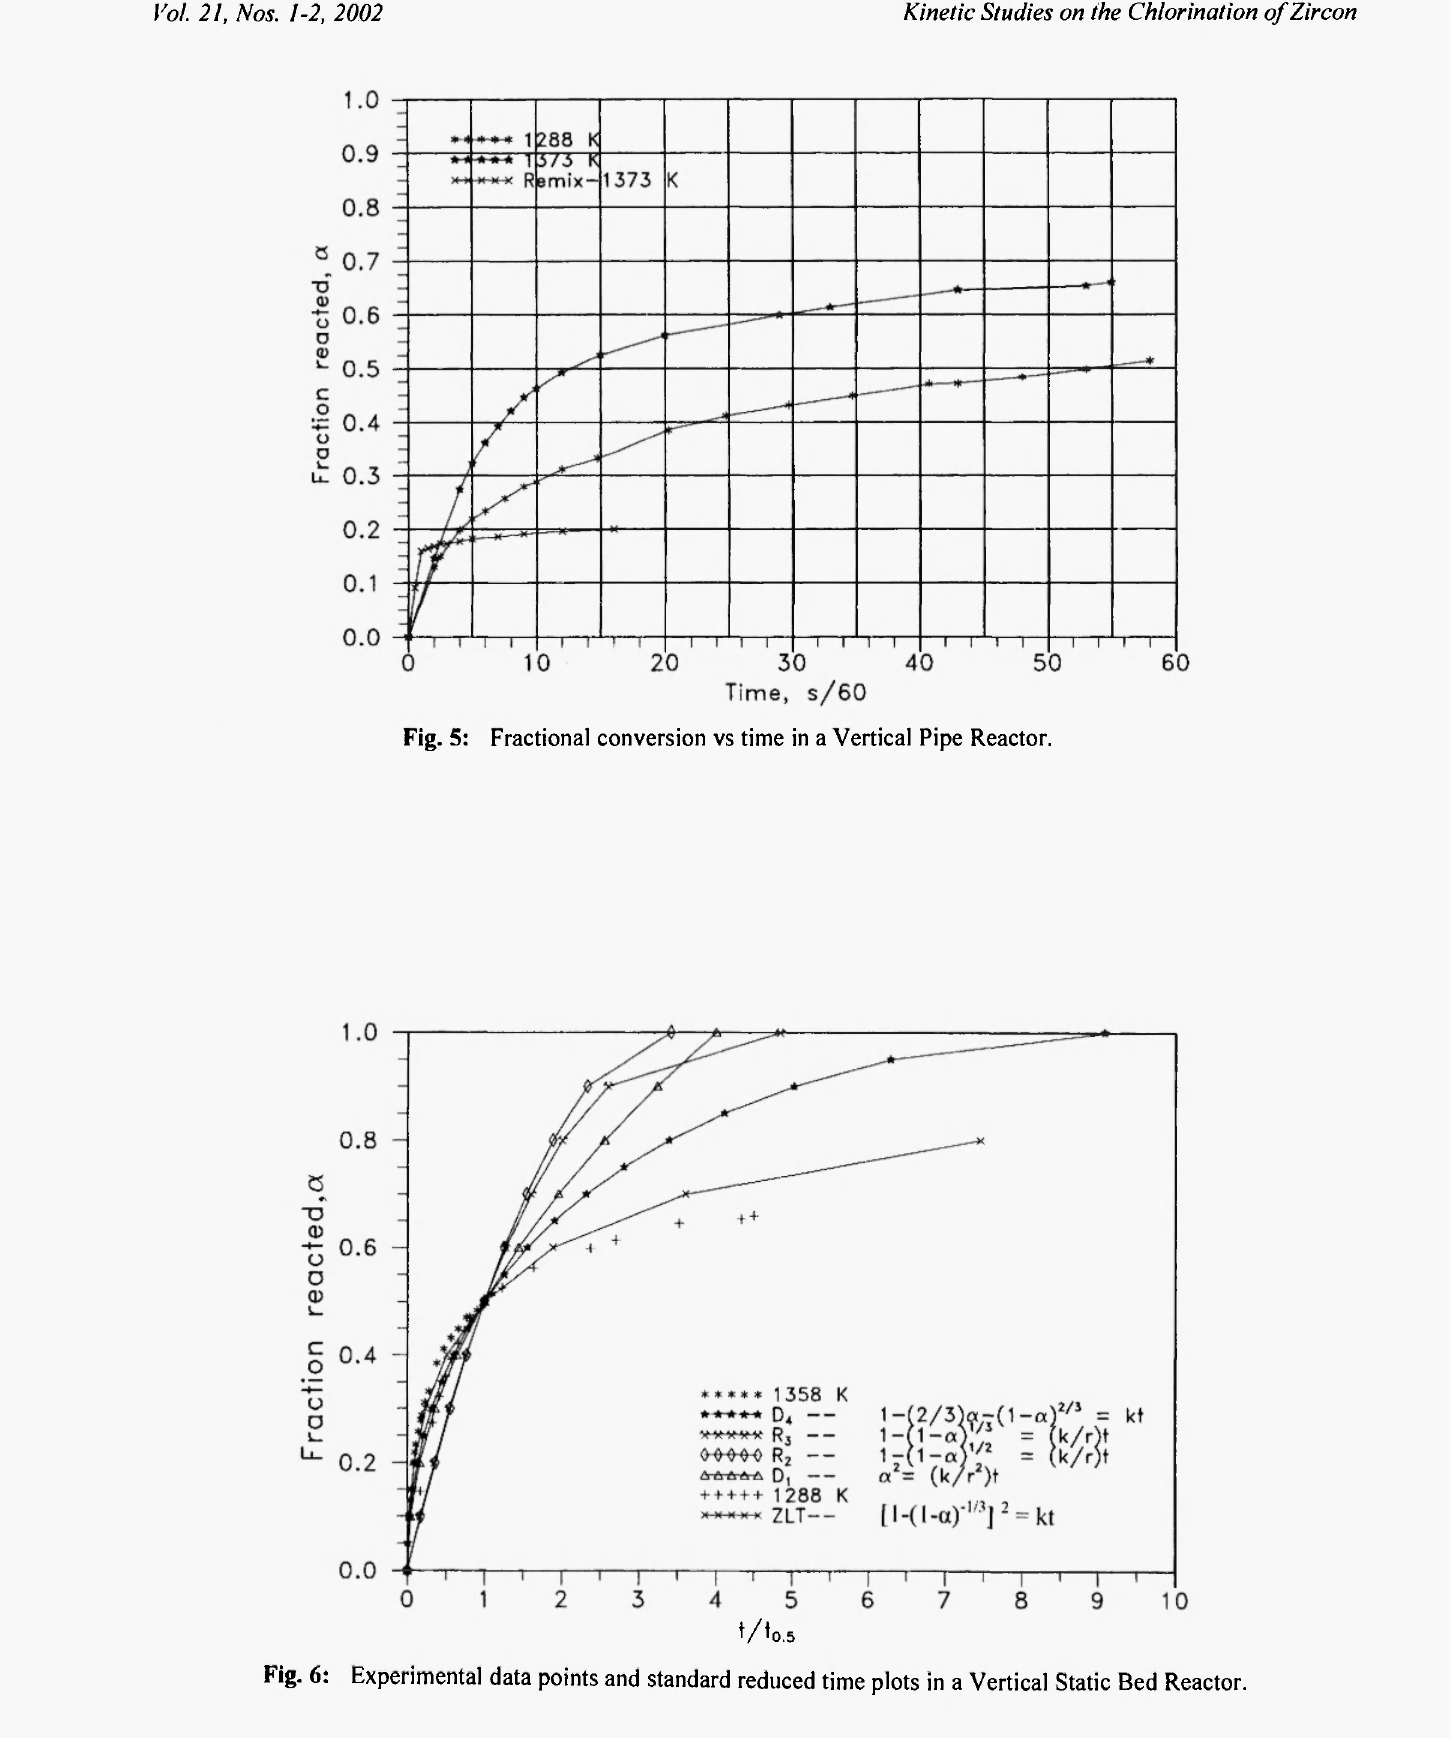
t/to .5 Fig. 6: Experimental data points and standard reduced time plots in a Vertical Static Bed